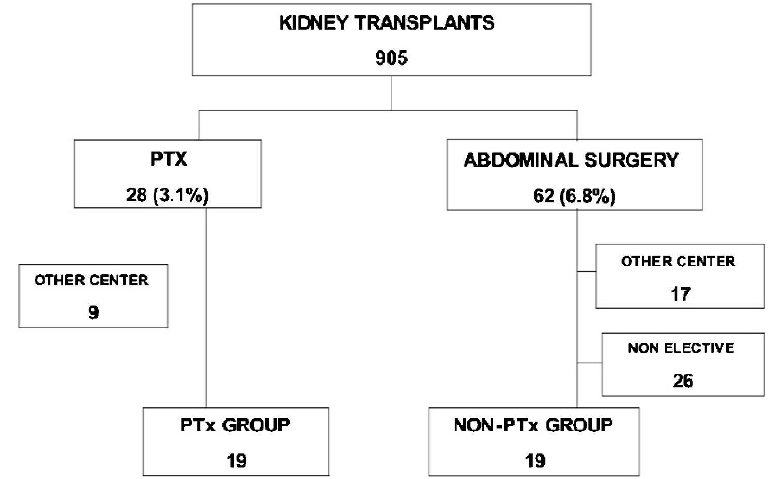
Figure 1 - Patient Selection (PTX =